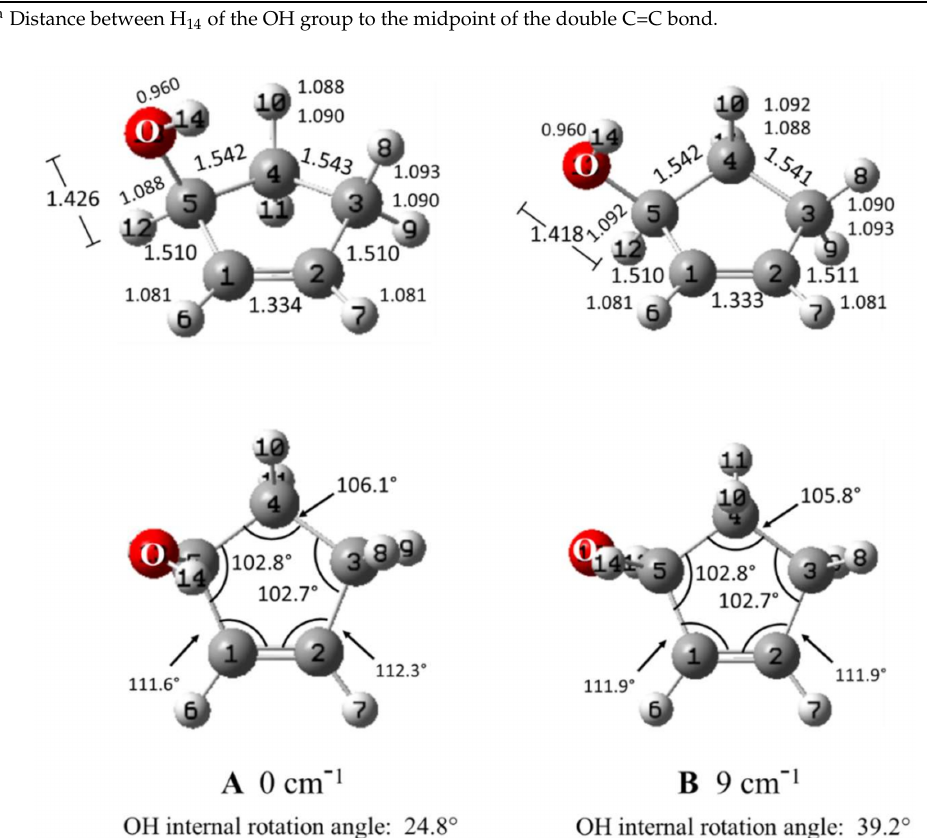
Figure 1. Calculated structures of the lowest energy conformers of 2CPOL from coupled-cluster theory with single and double excitations (CCSD)-pVTZ